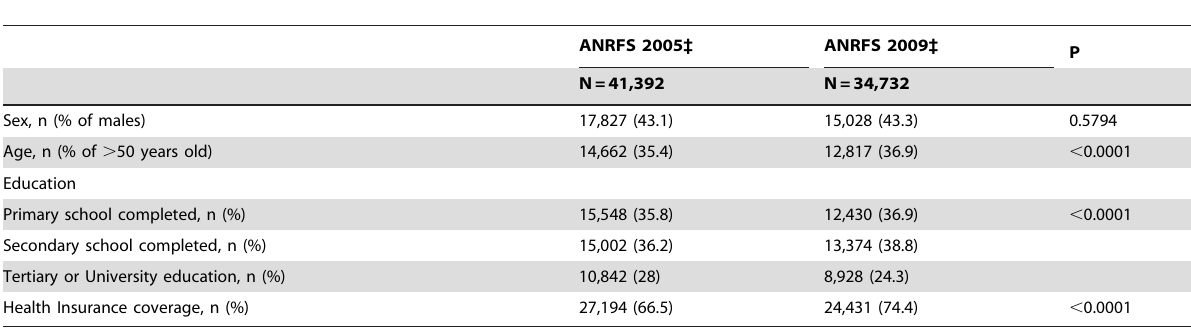
Table 1. Characteristics of the participants enrolled in both surveys.